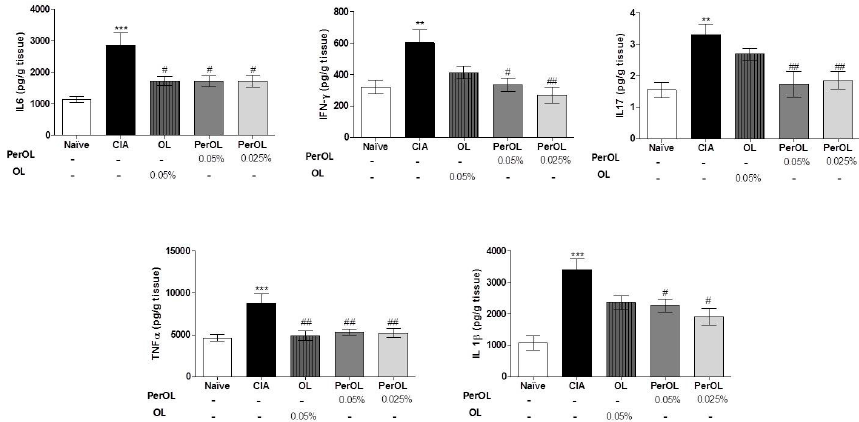
Figure 3. Measurement of pro-inflammatory cytokines: TNF- α , IL-1 β , IL-6, IL-17 and IFN- γ levels in hind paw homoge- nates. These were determined by ELISA kits. Data represent mean ± S.E.M., n = 12. ** p < 0.01 and *** p < 0.001 vs. SD-Naïve control group, # p < 0.05 and ## p < 0.01 vs. SD-CIA control group.